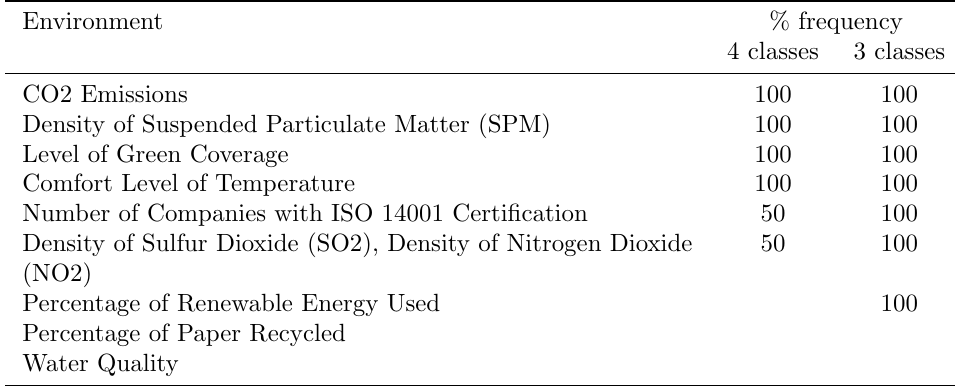
Table A.5: Frequency scores of the sub-sub factors of Environment Environment % frequency CO2 Emissions Density of Suspended Particulate Matter (SPM) Level of Green